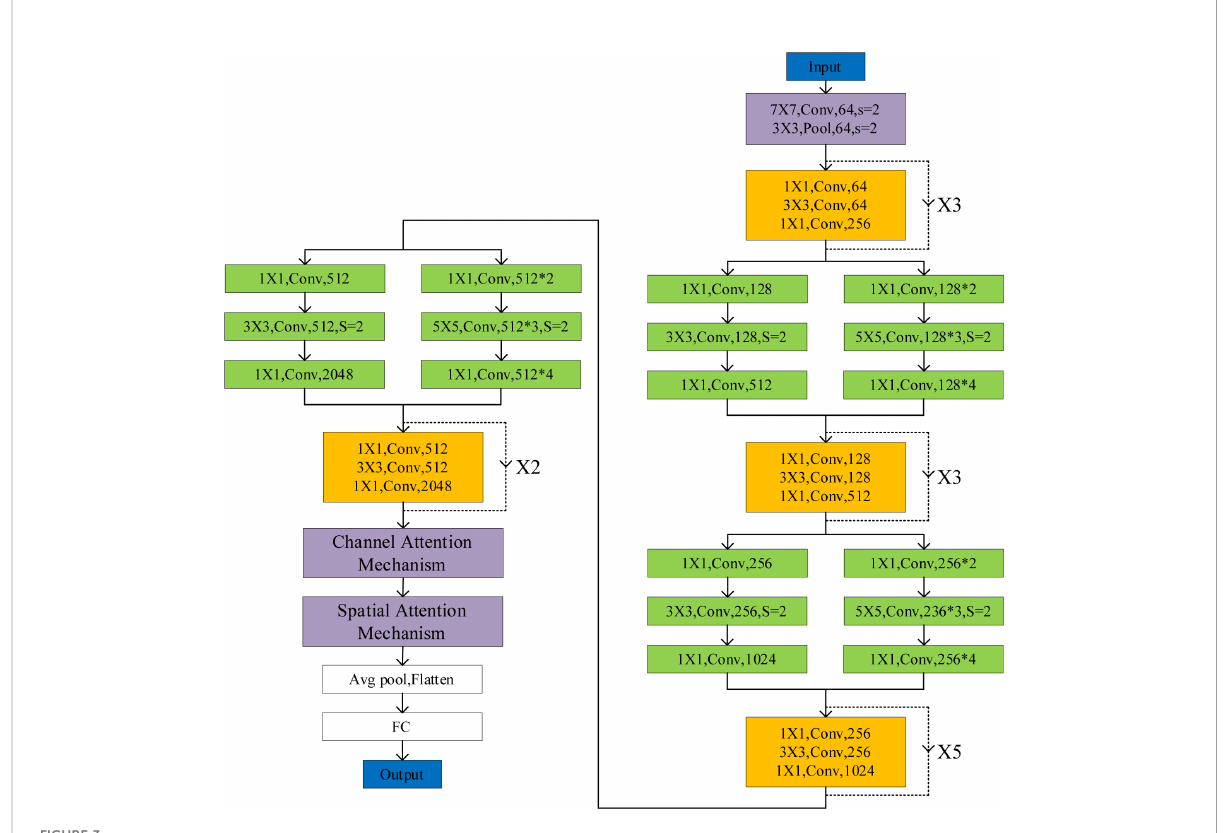
FIGURE 3 Overall structure of